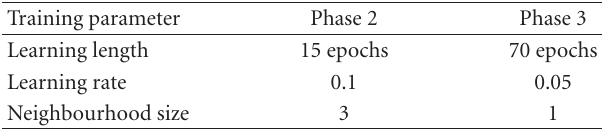
Table 1: Training parameters used for the SOM and GSOM train-